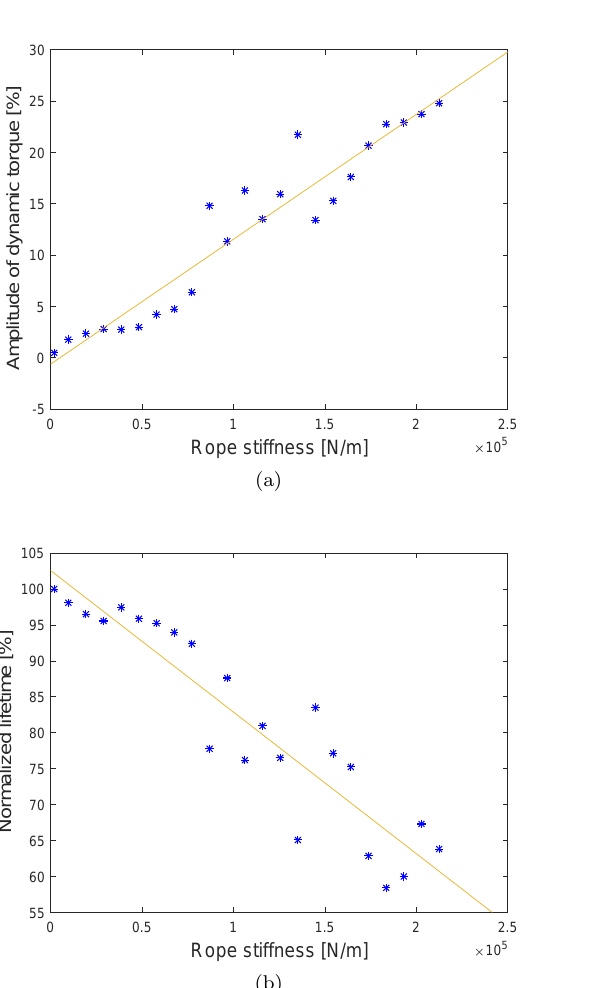
Figure 10: Effect of rope specific mass on static torque (top) and normalized lifetime